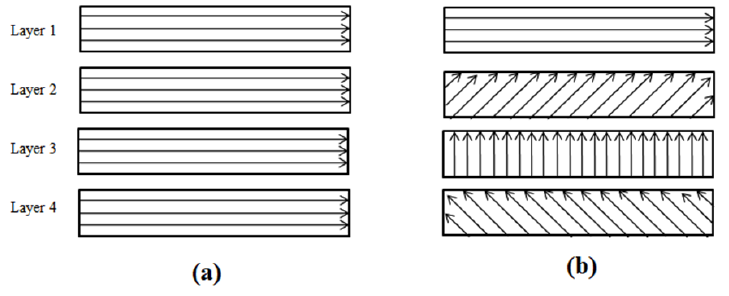
Figure 2. Laser beam scanning patterns ( a ) S1 ( b ) S2.